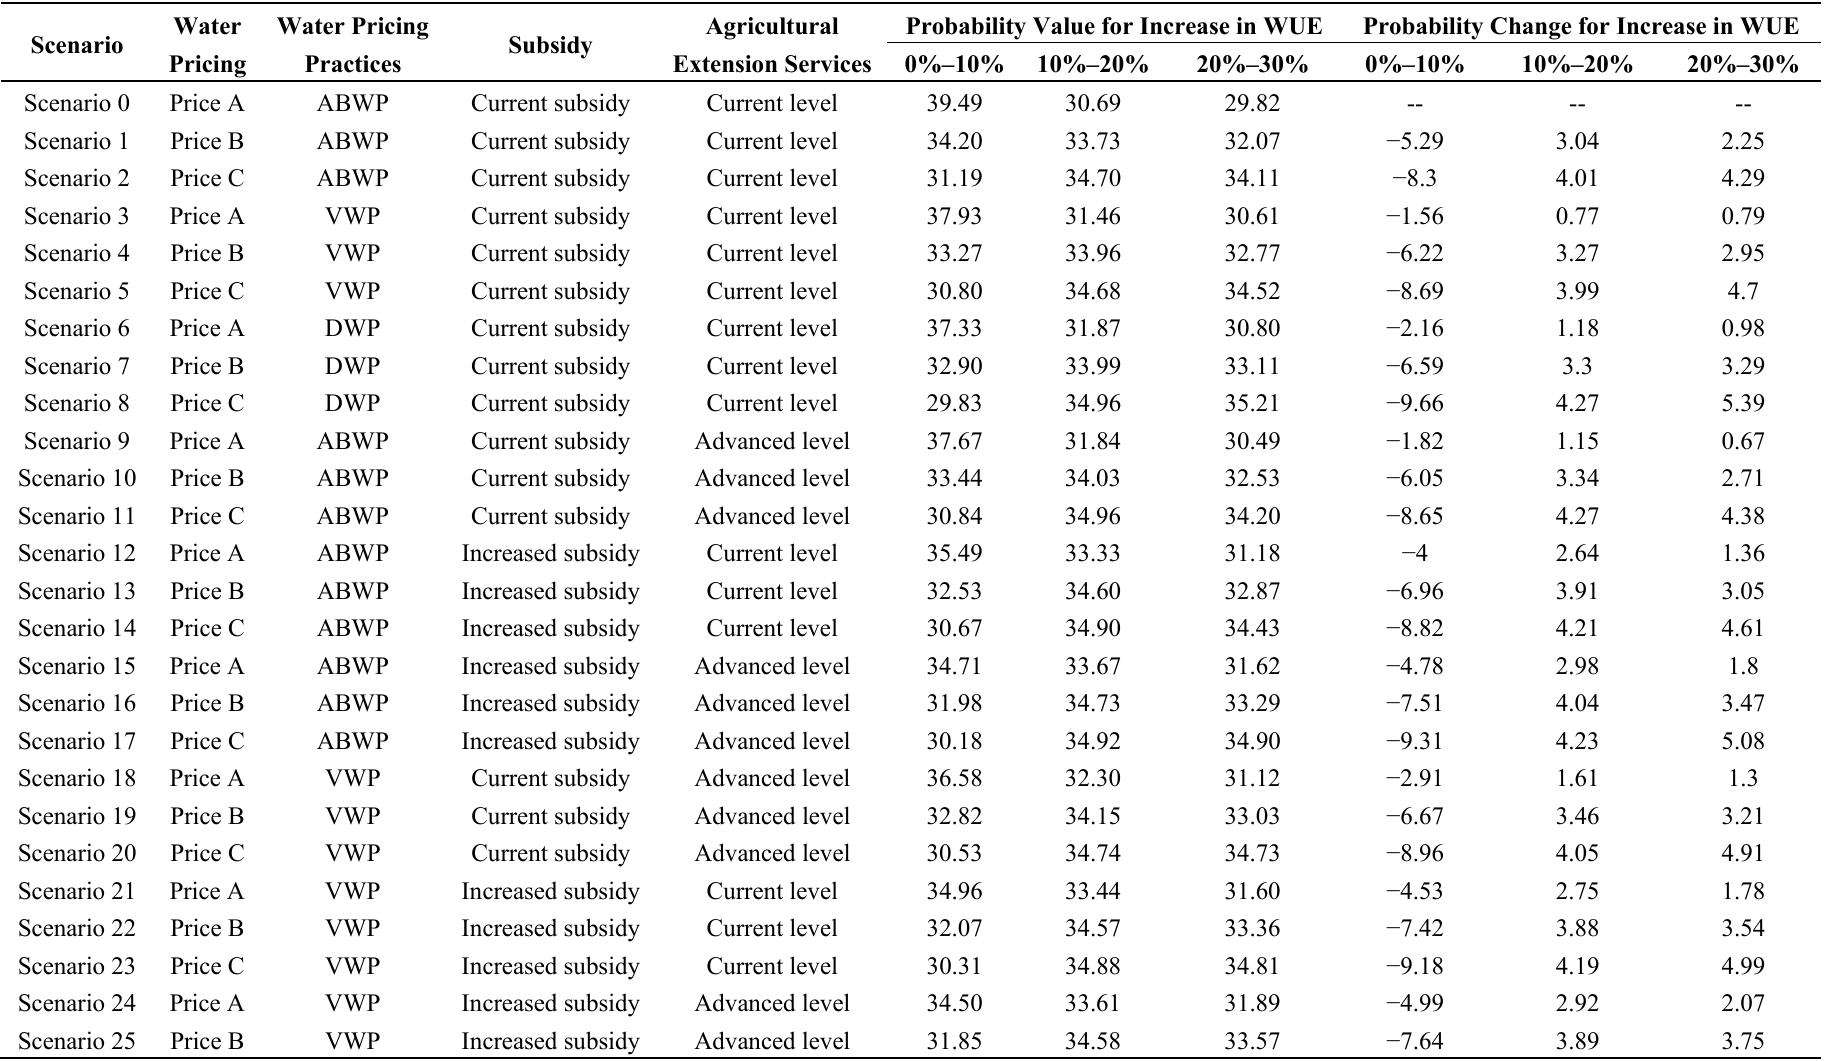
Table 4. Probability value of increases in WUE under different water pricing